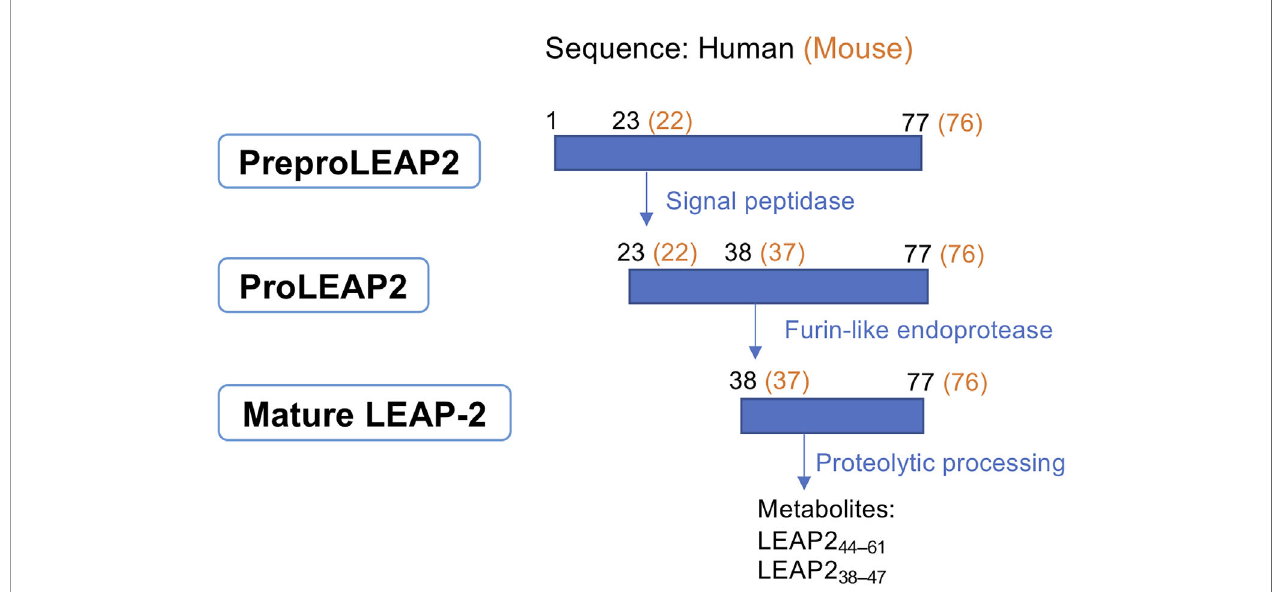
FIGURE 1 | Biological maturation of LEAP-2. PreproLEAP2 is processed into proLEAP2 and then the 40-residue mature LEAP-2 by signal peptidase and furin-like endoprotease. Mature LEAP-2 subsequently degrades into small metabolites through proteolytic processing. The LEAP-2 sequences of human and mouse are labelled in black and orange,